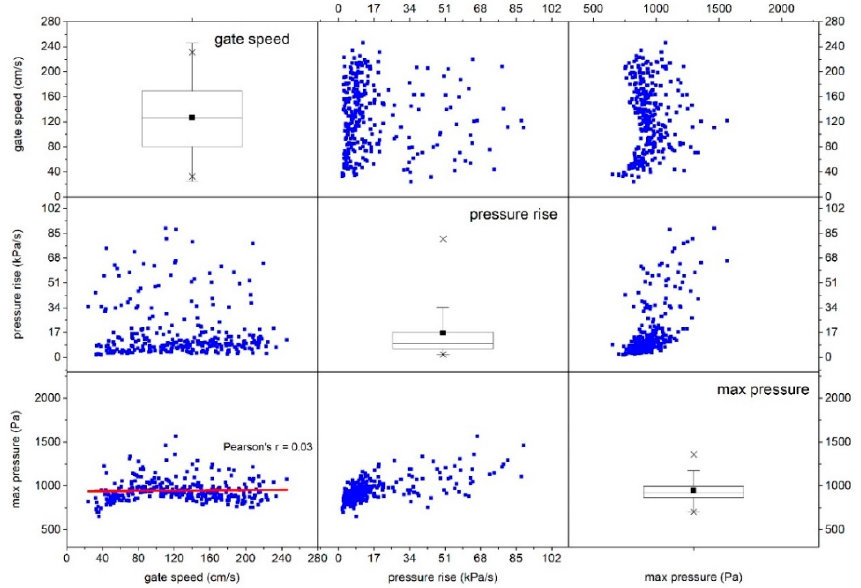
Figure A3. The matrix presenting the relationship between maximum pressure, pressure rise rate, and gate speed at Ch2.